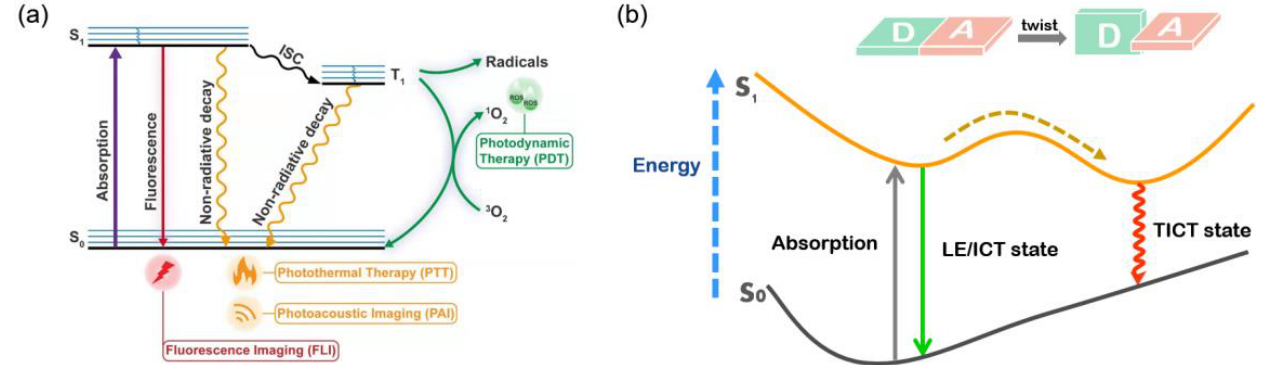
Figure 1. ( a ) Schematic illustration of Jablonski diagram. Reprinted with permission from Ref. [35]. Copyright 2021, Light Publishing Group; ( b ) the illustration of TICT mechanism.